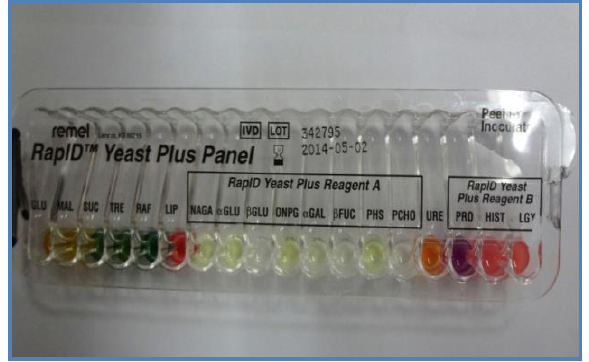
Fig. 4: Rapidtm yeast plus system show the positive reaction of Candida albicans.